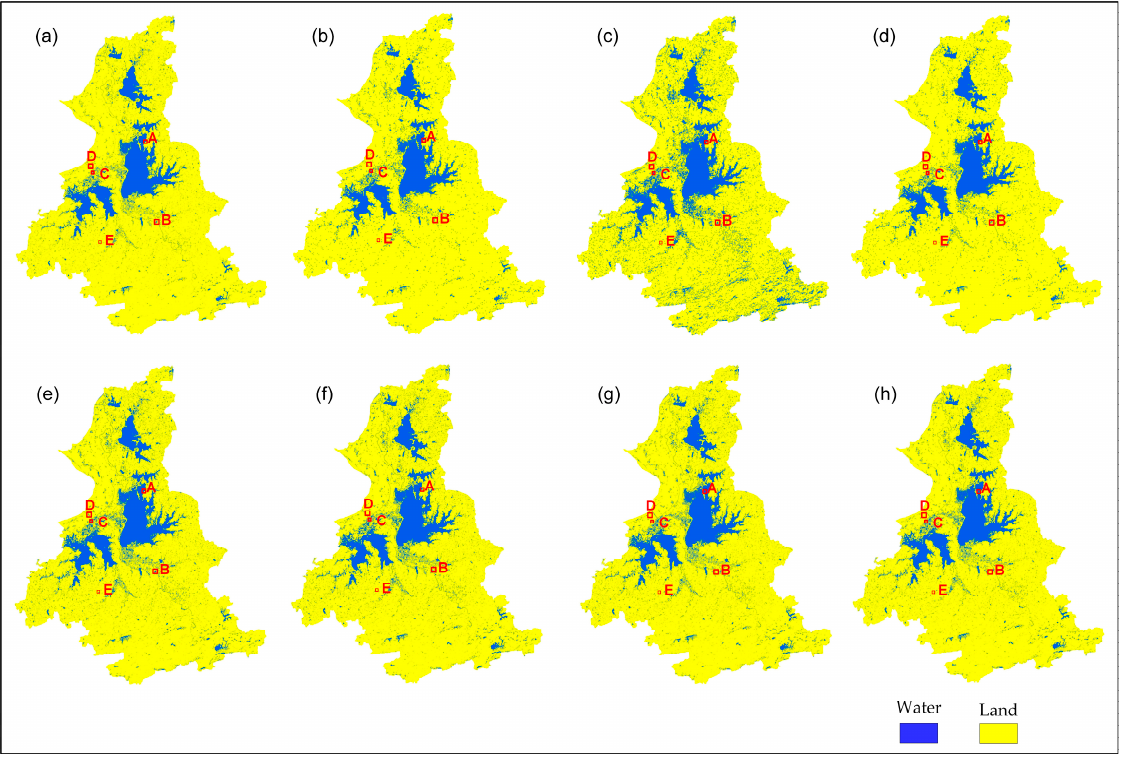
Figure 6. Resulting surface water maps from different methods. ( a ) NDWI_OTSU, ( b ) MNDWI_OTSU, ( c ) SVM, ( d ) UNet, ( e ) D_PSA, ( f ) D_MRF, ( g ) DE_PSA, and ( h ) DE_MRF (proposed). The enlarged areas of the five zoom-in areas (A, B, C, D, and E) are shown in Figures 7 and 8. The sub-pixel maps of D_PSA and DE_PSA contain many jagged boundary